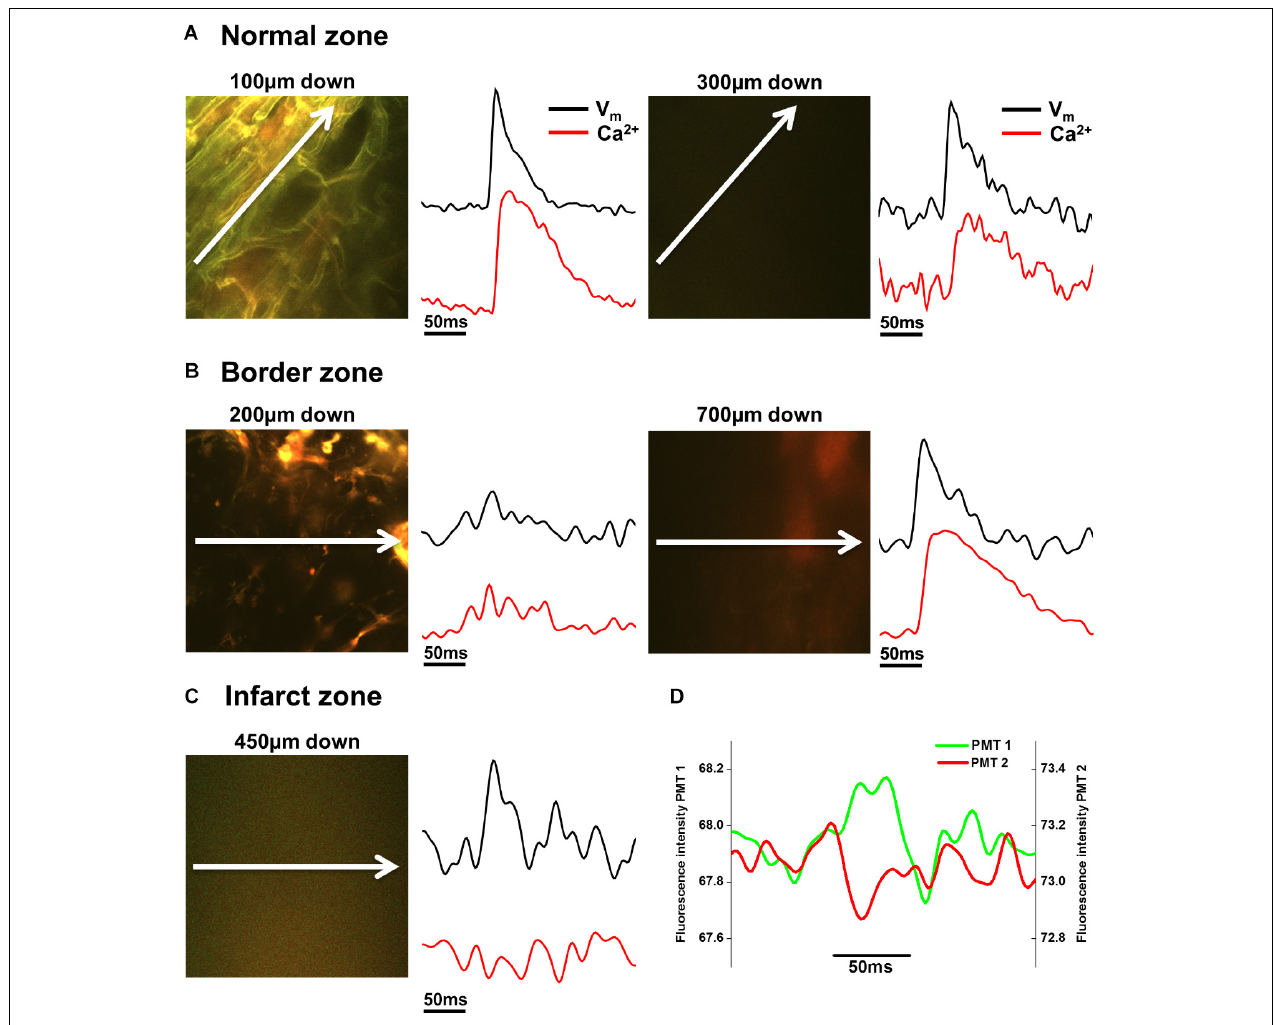
FIGURE 6 | Voltage and Ca 2 + measurements in normal zone (NZ), border zone (BZ), and infarct zone (IZ). (A) 2P image with corresponding voltage (Vm) and intracellular calcium (Ca 2 + ) transients taken from the NZ 100 µ m (left panels) and 300 µ m (right panels) below the tissue surface. Vm and Ca 2 + signals were of normal morphology in these areas. (B) In the BZ, toward the surface (here at 200 µ m down), structures appear to resemble connective tissue and no Vm or Ca 2 + signals were apparent (left panels). However, deeper into the tissue (700 µ m down in this example) fluorescence signal with no defined structures can be detected in the 2P image, and Vm and Ca 2 + signals with good signal-to-noise were recorded (right panels). (C) Within the IZ, in this example, no structures could be resolved in the 2P image at 450 µ m down. However, low amplitude voltage signals were detected, with no detectable Ca 2 + signal in the same region (left panels). (D) The individual PMT signals indicate that the voltage signals are not arising from movement artefact, as short and long wavelength signals are not the same. White arrows indicate length and direction of line scan. Vm and Ca 2 + signals shown are the average of 25 APs/Ca 2 + transients recorded over a period of 5